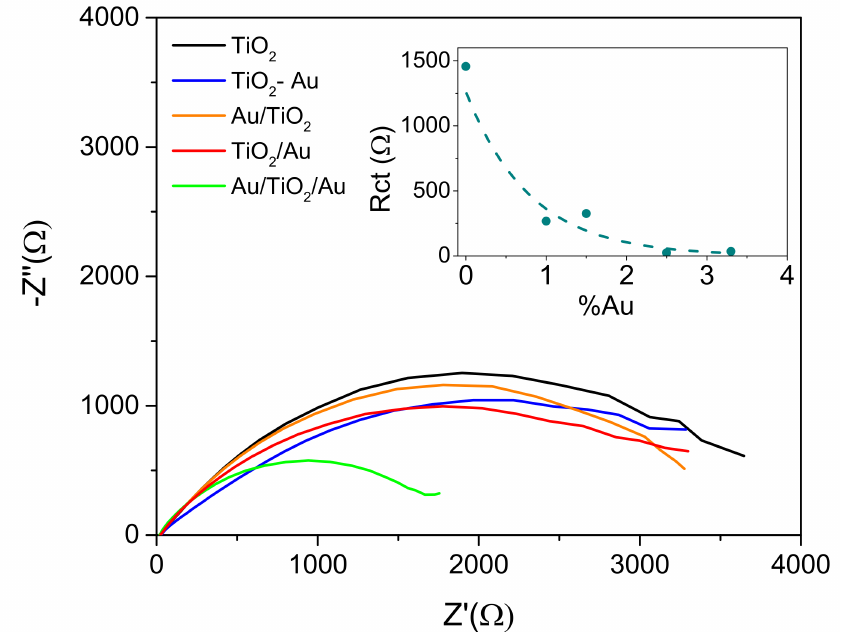
Figure 5. Nyquist plots obtained at V = − 0.5 V vs SCE, in supporting electrolyte, at different samples. Inset: trend of R ct evaluated by fitting the EIS data with a Randle